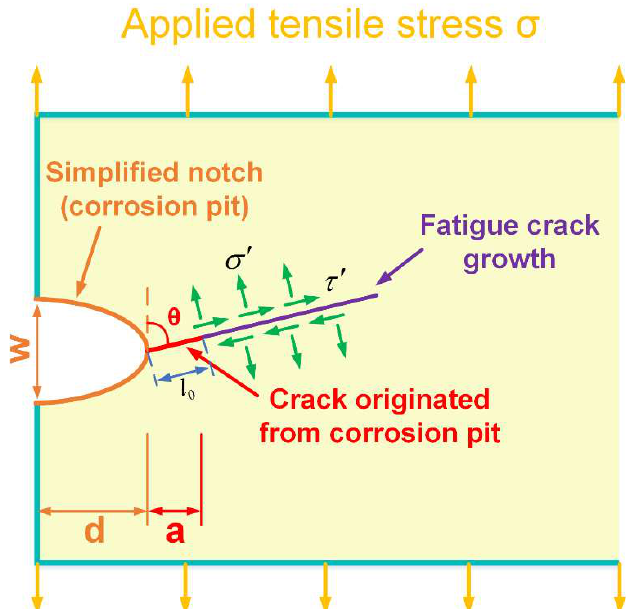
Figure 13. Schematic diagram of simplified mixed-mode crack mode for fatigue crack growth from a corrosion pit.